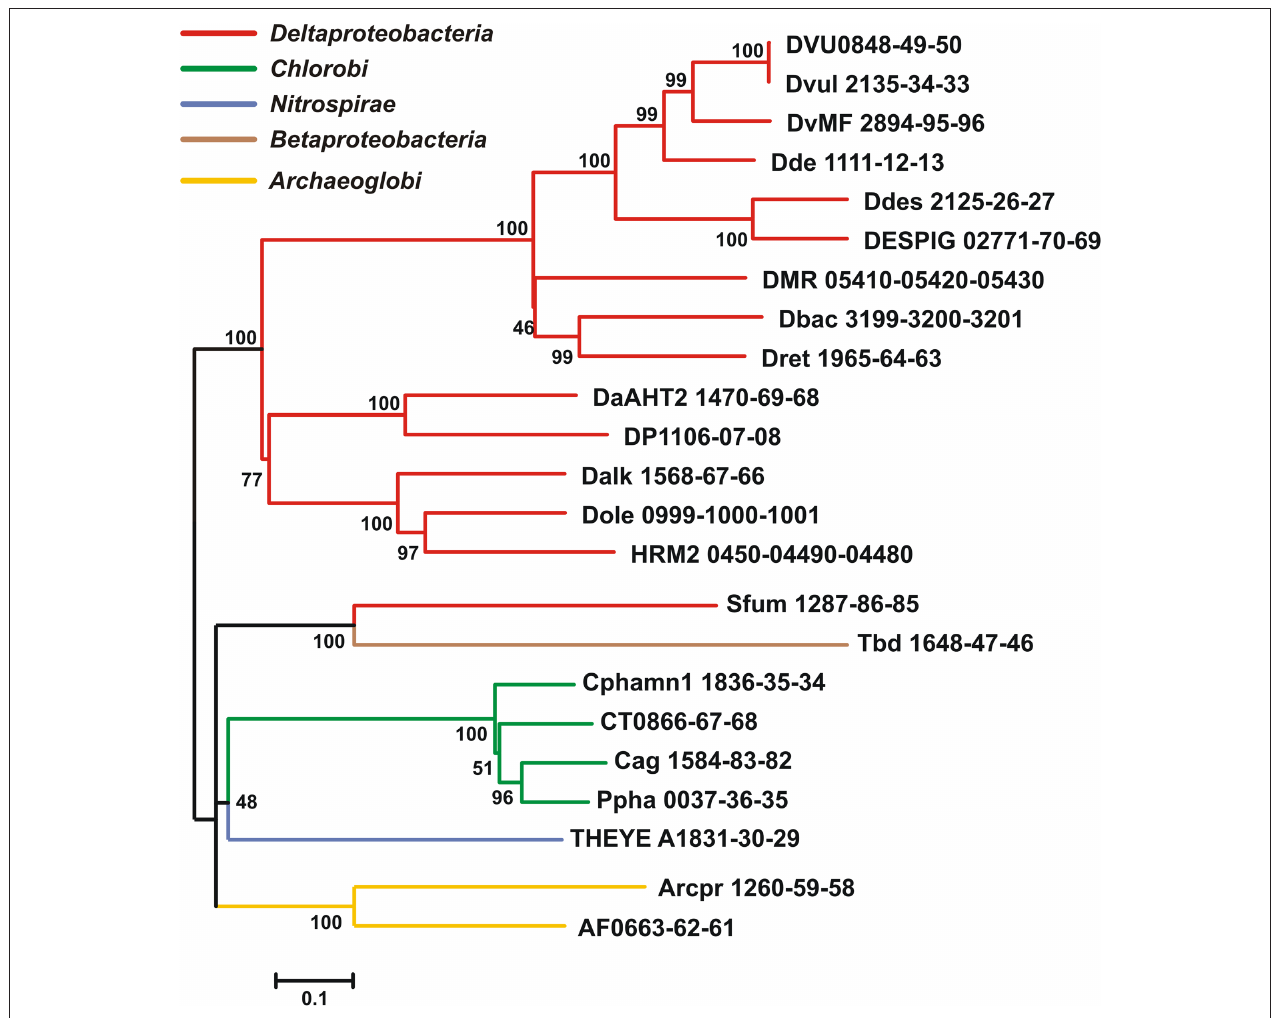
FiGurE 2 | Maximum likelihood phylogeny inferred from concatenated QmoABC amino acid sequences. The tree was constructed in MEGA5 using the WAG model of amino acid substitution with a gamma distribution = 1.8288 across five rate categories to account for differential substitution rates between sites and an invariable site frequency of 9.82%. A total of 1479